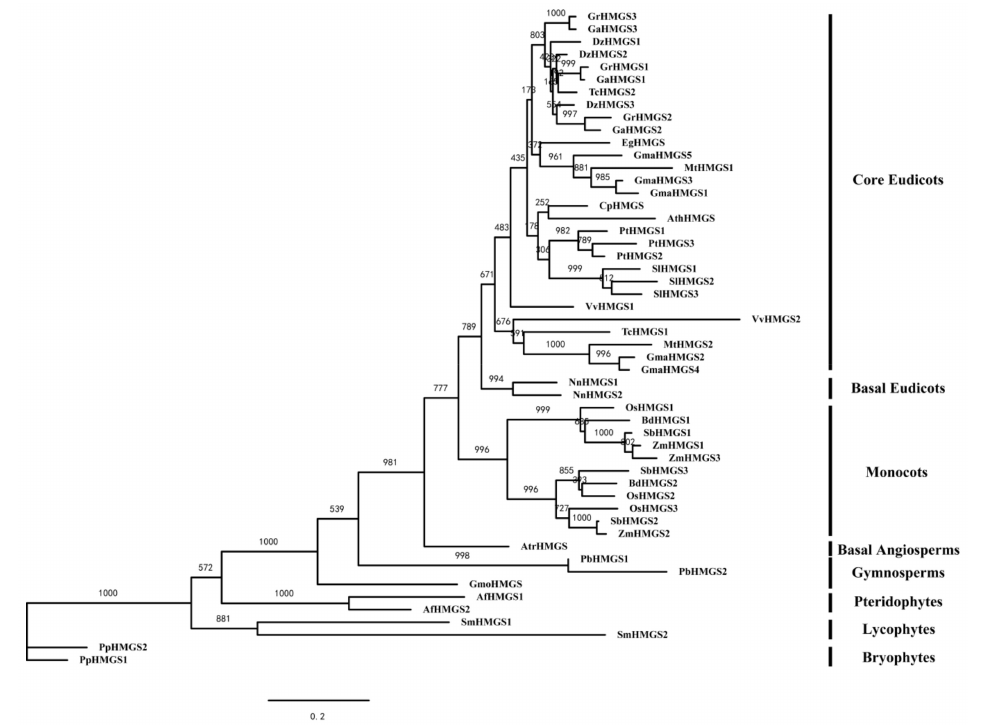
Figure 2. Phylogenetic tree based on HMGS proteins from G. raimondii , G. arboreum , and 24 other species. The phylogenetic tree was constructed with the ML method of the JTT model in the PhyML software. The bootstrap analysis was conducted with 1000